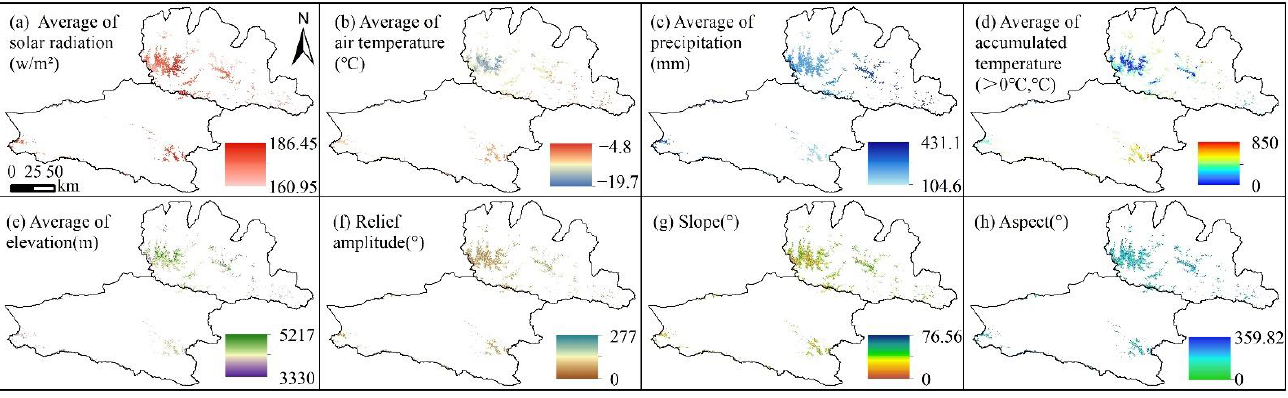
Figure 6. Driving factors affecting glacier mass balance. ( a ) Average of solar radiation (w/m 2 ); ( b ) Average of air temperature (°C); ( c ) Average of precipitation (mm); ( d ) Average of accumulated temperature (>0 °C, °C); ( e ) Average of elevation (m); ( f ) Relief amplitude (°); ( g ) Slope (°); ( h ) Aspect (°).